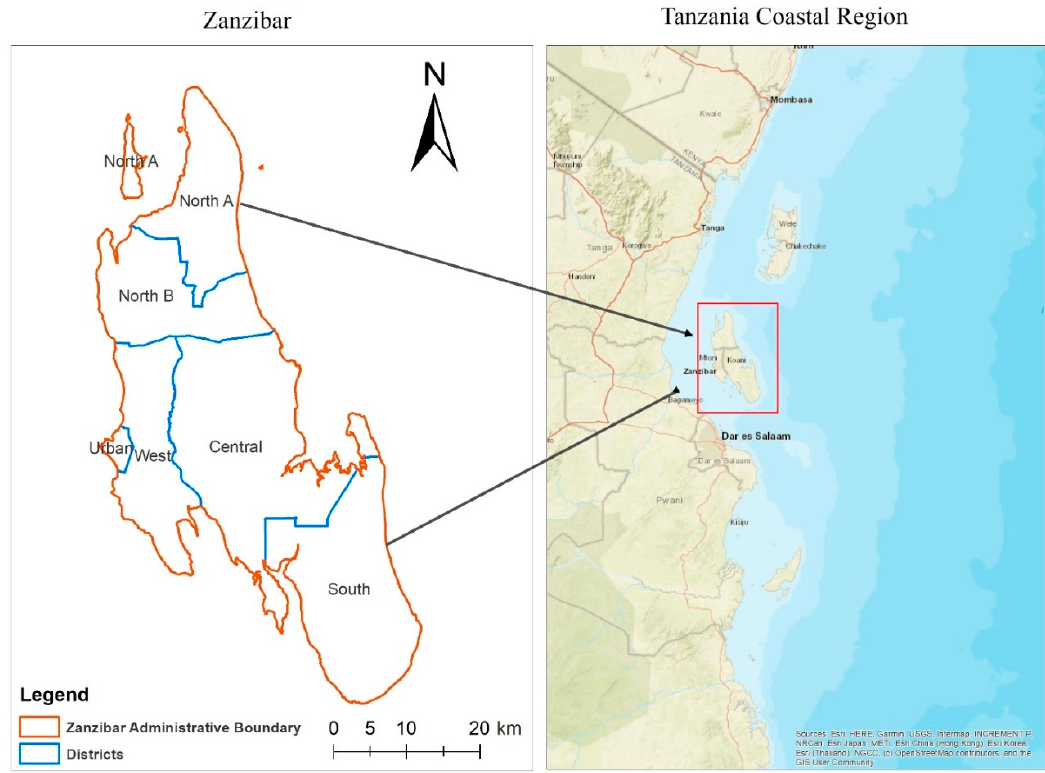
Figure 1. Study area in Zanzibar.